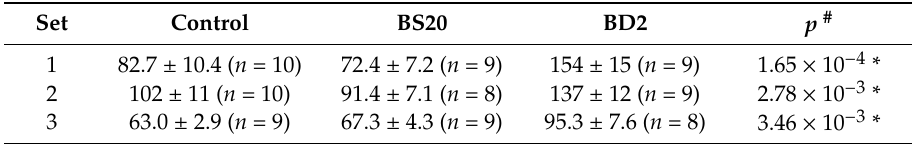
Table 5. Mean number of apoptotic events ( ± SEM) obtained in the control, BS20 and BD2 groups from 3 sets of experiments. n : numbers of embryos involved in the analyses. # p values obtained by comparing the BS20 and BD2 groups using the one-tailed t -test (cases with p < 0.05 are